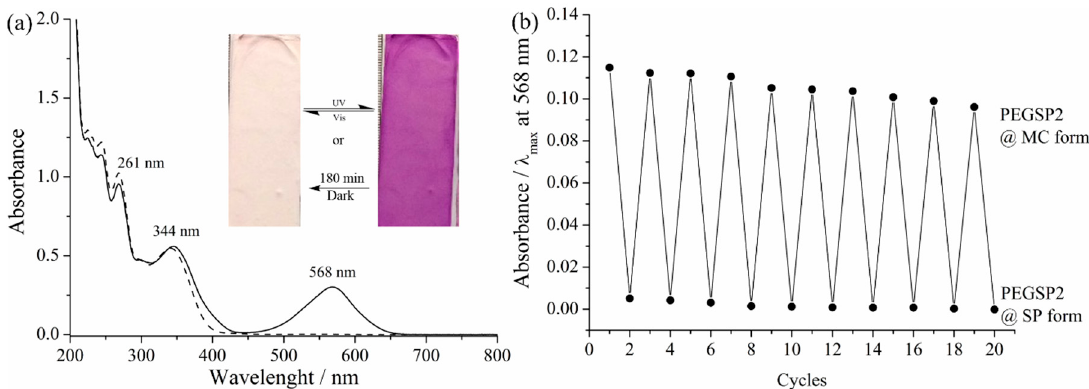
Figure 5. ( a ) Electronic spectra of PEGSP2 isomers (dash line) for closed form - SP, and (solid line) for open form - MC in MeCN. Insert photograph of ES nanofibers after visible light irradiation and after UV irradiation and ( b ) absorbance measurements of irradiation cycles (visible and UV lights) in PEGSP2 MeCN solution.